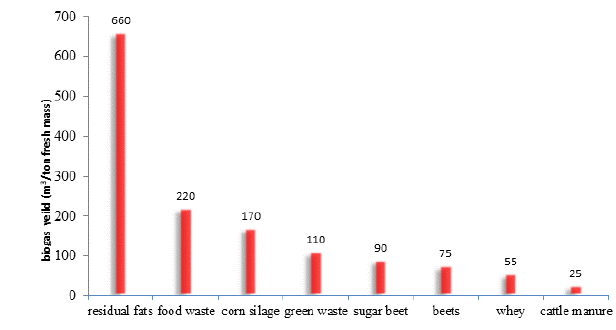
Figure 1. Comparison of renewable energy costs in KSA.